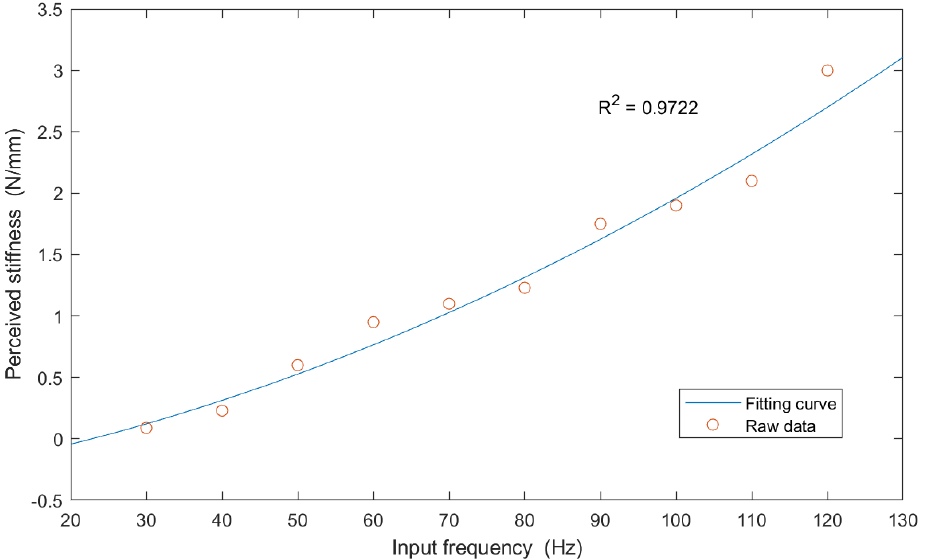
Figure 10. Fitting curve of equivalent perceived stiffness corresponding to the input frequency of the voice coil motor.